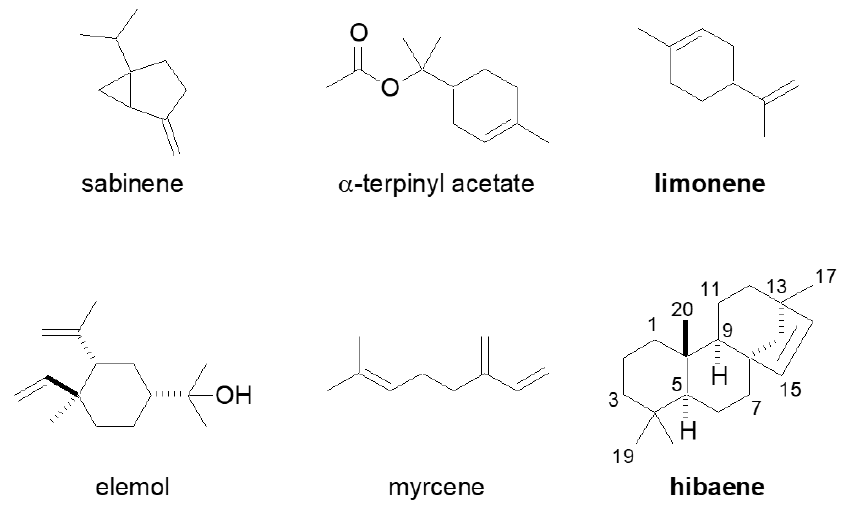
Figure 1. Major components in hinoki leaf oil.